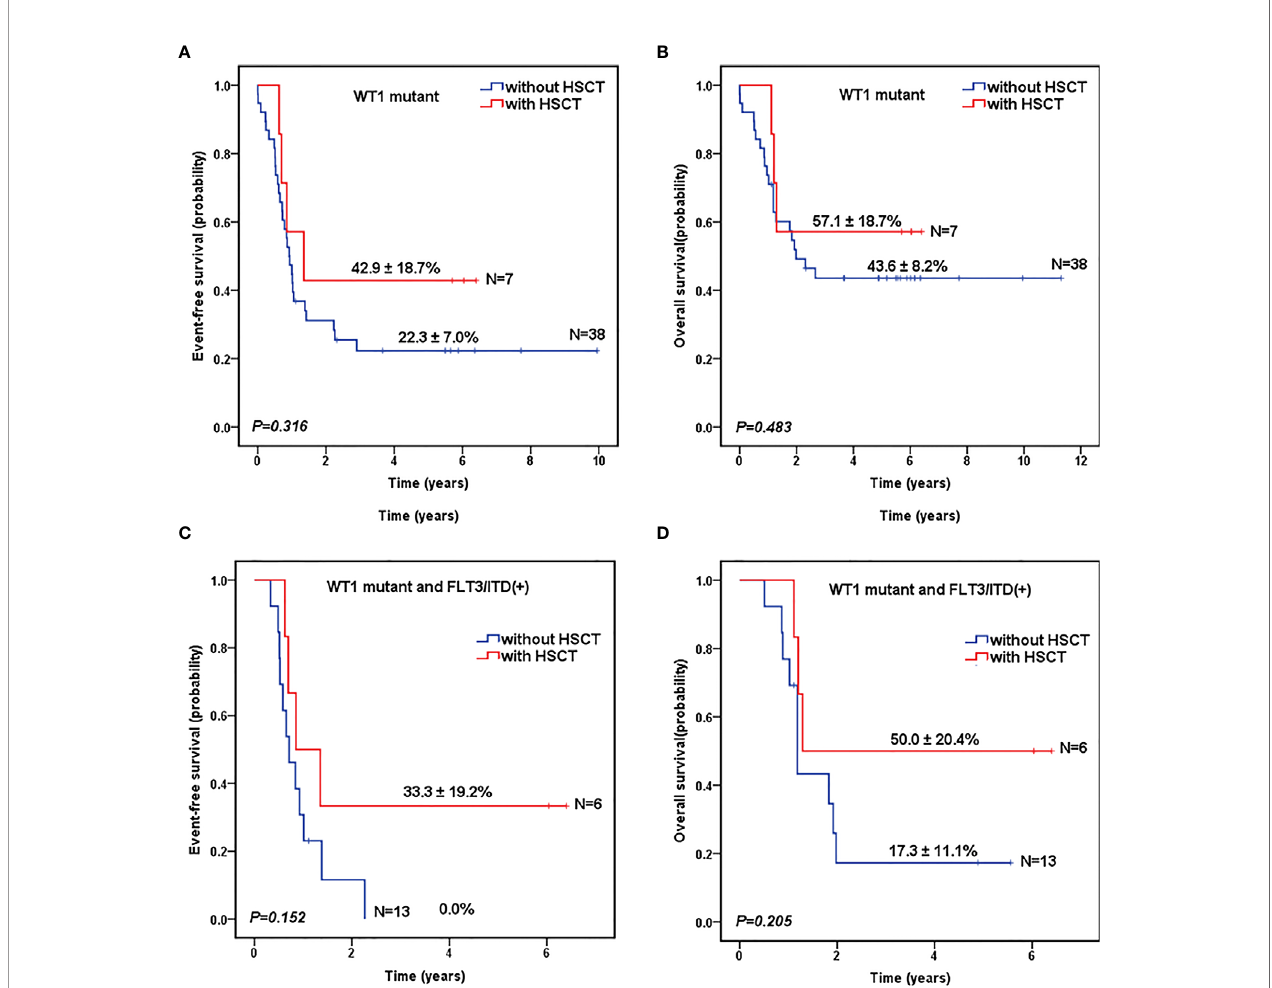
FIGURE 3 | Survival curves of pediatric AML patients according to WT1 mutations and hematopoietic stem cell transplantation (HSCT) status. Probability of EFS (A) and OS (B) for patients with WT1 mutations according to HSCT status, respectively. Probability of EFS (C) and OS (D) for patients with WT1 mutations and FLT3 / ITD positive according to HSCT status,